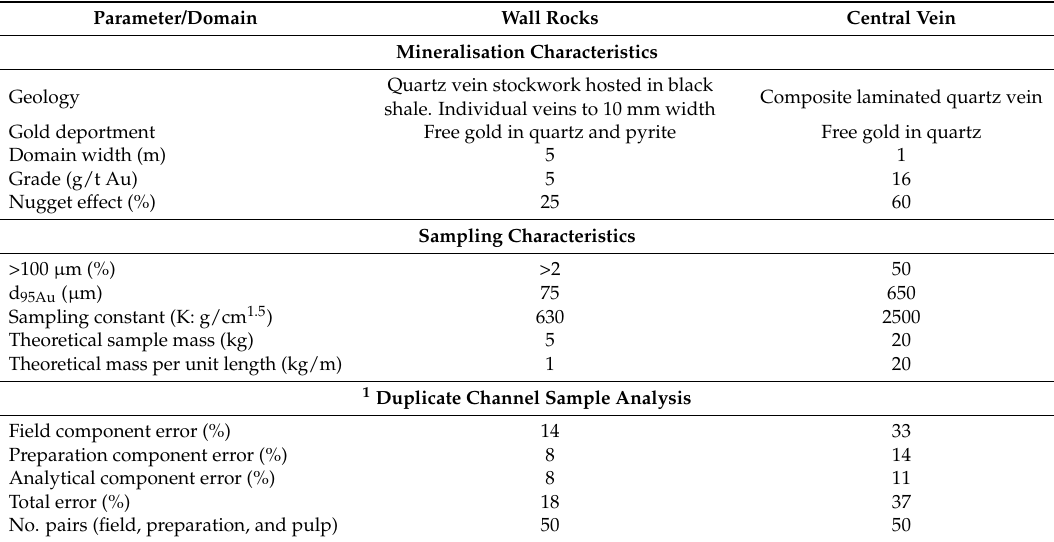
Table 5. Example from a South American project of sampling characteristics for vein-stockwork wall rock mineralisation